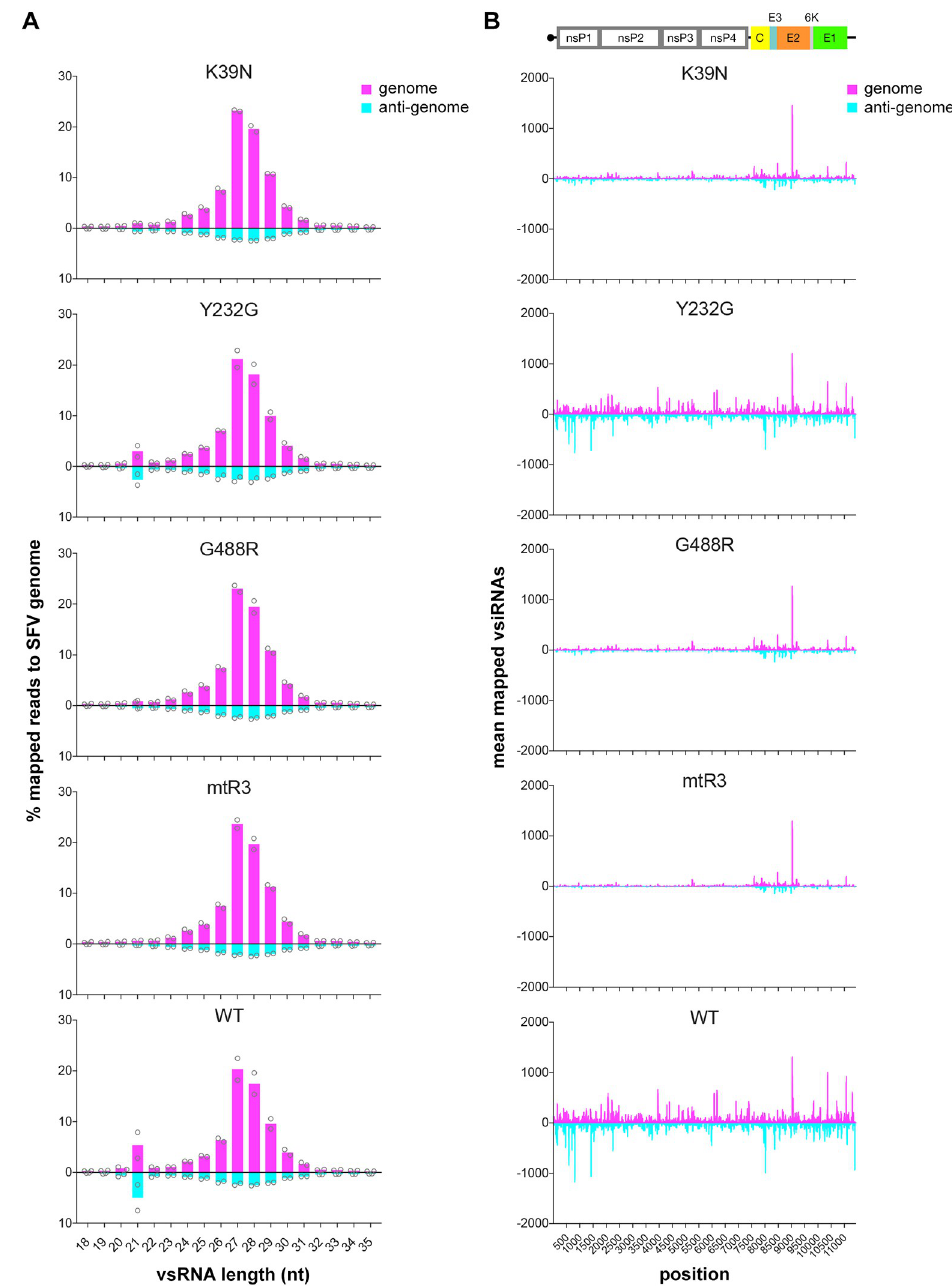
Fig 4. Domain loss-of-function mutations in Aaeg Dcr2 affect vsiRNA production. (A) Distribution of 18–35 nt vsRNAs mapped to the SFV (GenBank ID: KP699763) genome (sense; magenta) or anti-genome (anti-sense; cyan) shown as mean % mapped reads in bars with replicates shown as circles from n = 2 independent repeats from AF319 cells transiently expressing mutant or WT Dcr2 and infected with SFV (MOI = 1) at 48 hpi. (B) SFV-derived 21 nt vsiRNAs from (A), mapped to SFV genome (magenta) or anti-genome (cyan) with the mean number of mapped reads shown from n = 2 independent repeats. The SFV genome organization (top panel) is shown for reference.